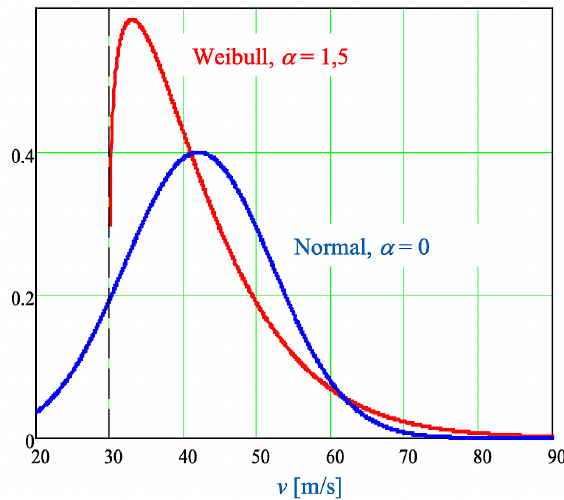
Figure 1. Weibull and normal distribution for µ = 42 m/s and σ = 10